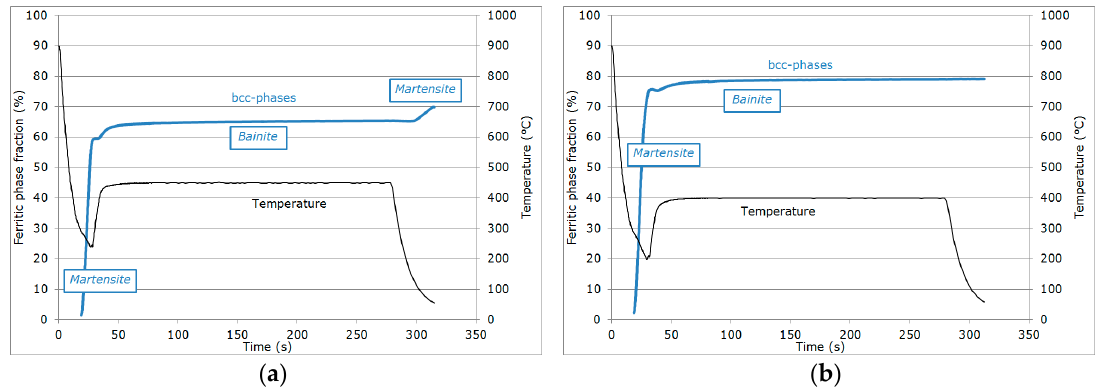
Figure 4. Evolution of phase fractions and temperatures as a function of time measured along two different Q&P cycles defined by: ( a ) QT = 230 ◦ C/PT = 450 ◦ C, and ( b ) QT = 200 ◦ C/PT = 400 ◦ C. Compared to the reference cycle, the bainite fraction formed was similar (+7%) at a higher PT (PT = 450 ◦ C). Nevertheless, the initial martensitic fraction was slightly lower (58%), as the QT reached was slightly higher (237 ◦ C). Due to the fast transformation kinetics, a minor deviation in the QT can have a significant effect on phase fractions. As the secondary martensitic transformation started at 150 ◦ C, the final martensite fraction (+5%) was higher than in the reference case. Finally, the final fraction of retained austenite at RT was about